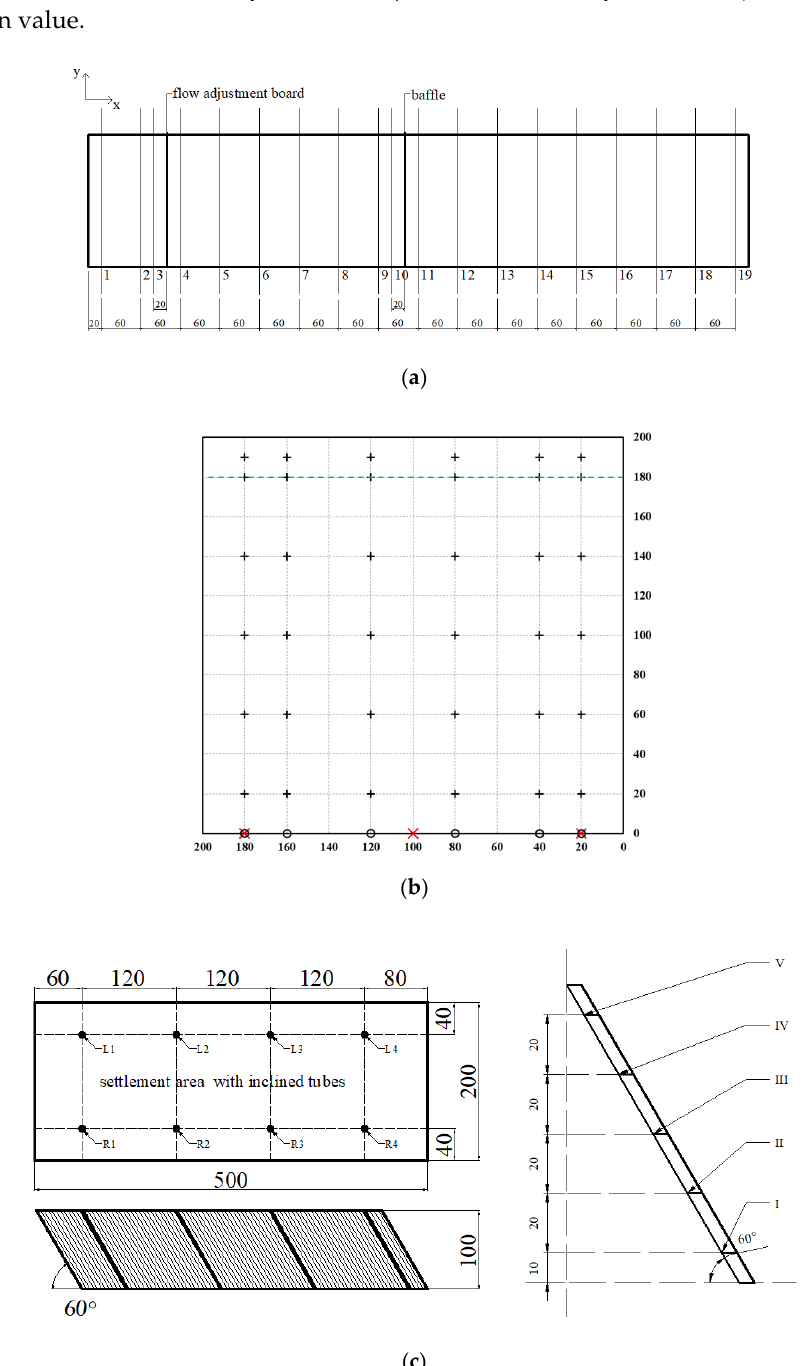
Figure 4. Measurement locations: ( a ) locations of measurement sections, ( b ) measurement locations arrangement in each section, and ( c ) measurement locations of inclined tubes (all the dimensions are in